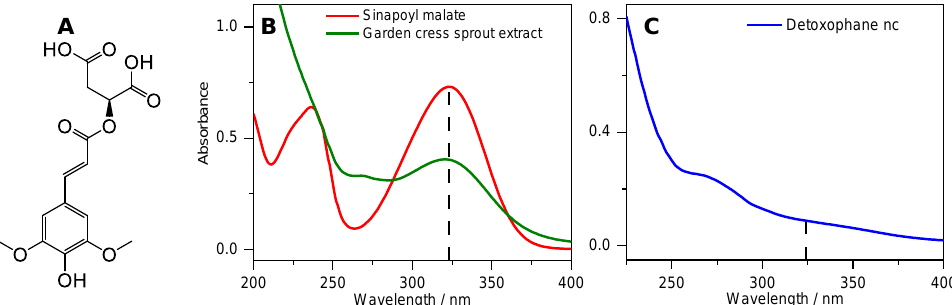
Figure 1. ( A ) Molecular structure of trans -sinapoyl malate. UV–Vis spectra of samples obtained for ( B ) 0.01 mg/mL trans -sinapoyl malate in water (red), 0.1 mg/mL of garden cress sprout extract in water (green), and ( C ) Detoxophane nc diluted at a ratio of 1:100 in water.